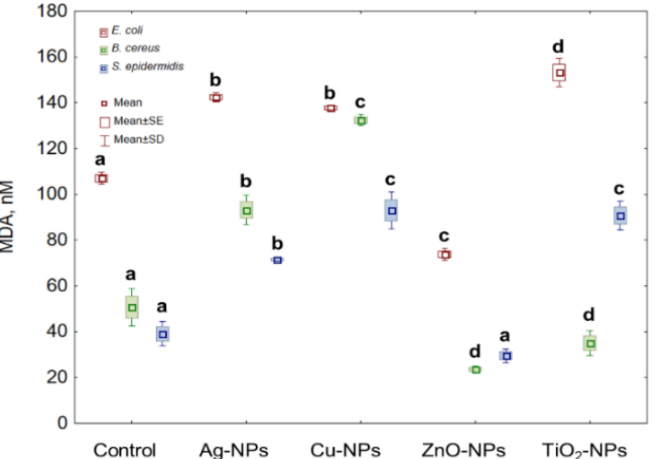
Figure 5. The LPO level in E. coli , B. cereus and S. epidermidis cells exposed to NPs at an IC 50 value (mean ± SD/SE; n = 3). Means with the same letter(s) are not significant at p < 0.05 between the control and NPs-treated cells.